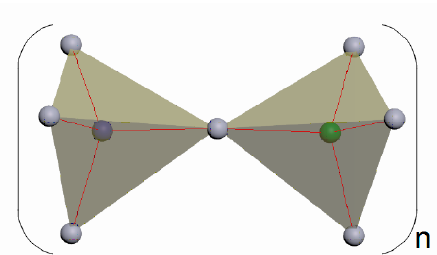
Figure 3. Bonding of TO 4 tetrahedra via oxygen atoms (n is the number of Si-O bonds) [compiled by the authors].